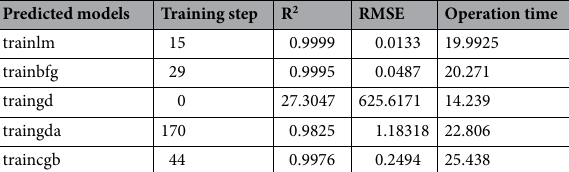
Table 2. Evaluation index of different learning algorithms.